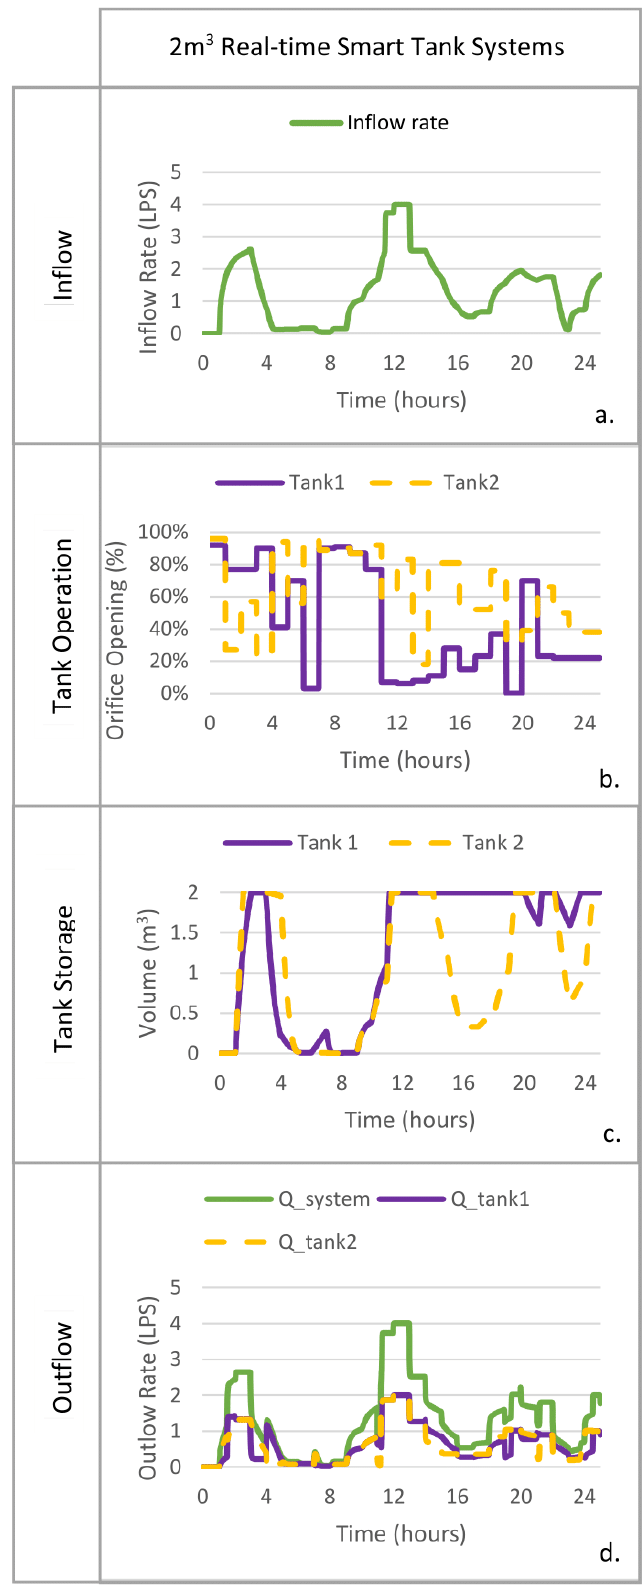
Figure 8. Typical operation rules for real-time smart tank systems approach for systems where the ratio of tank:runoff volume is less than 0.15 (Sydney, 24 h duration, 1% AEP).